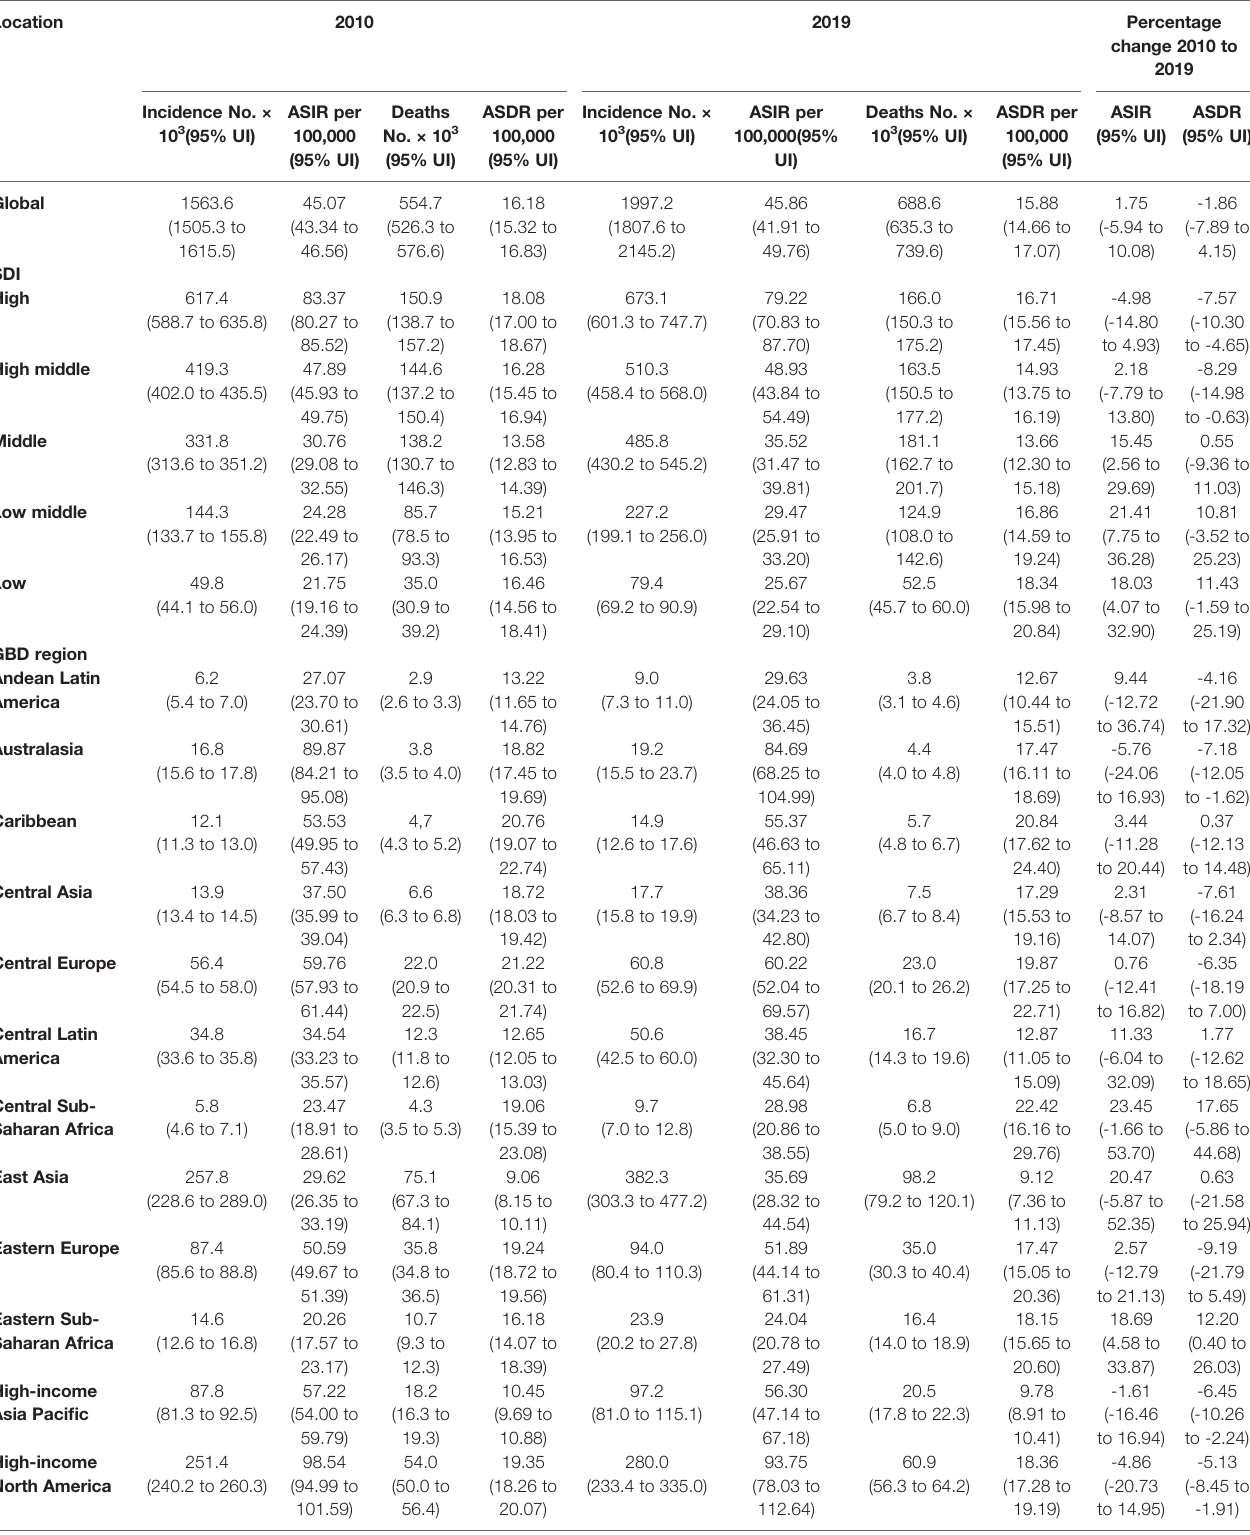
TABLE 1 | The incidence and death cases and their age-standardized rates of female breast cancer in 2010 and 2019, and the percentage changes from 2010 to 2019.